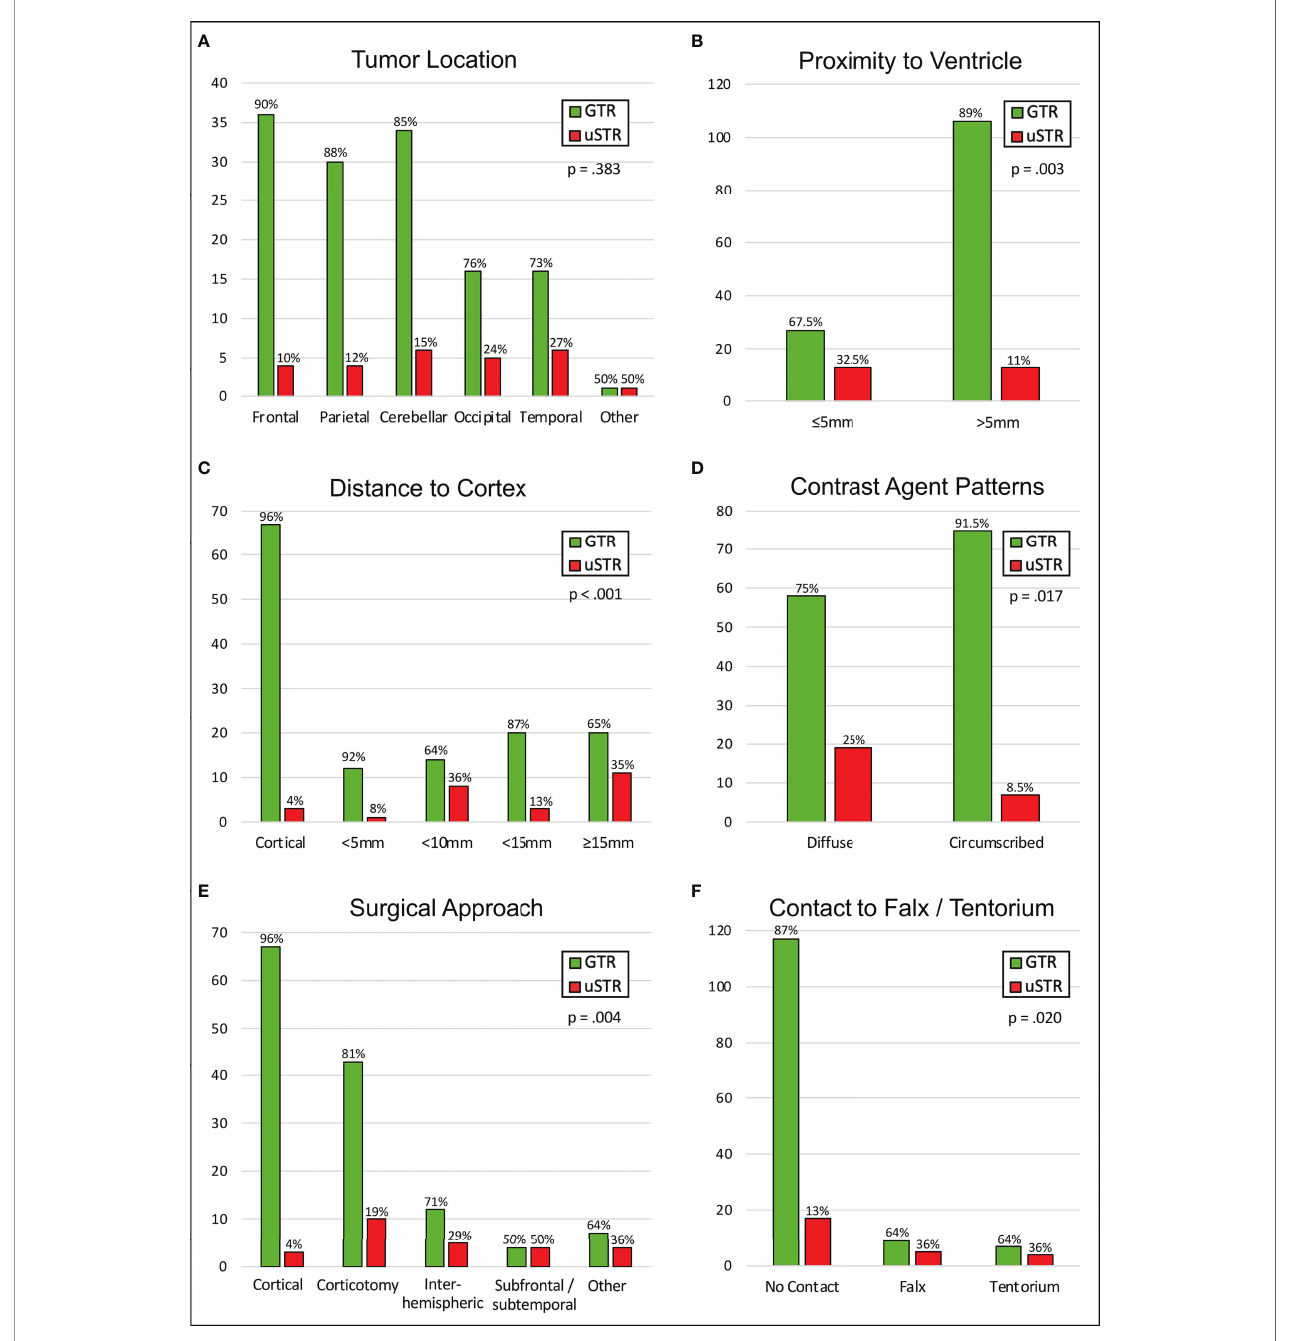
FIGURE 2 | Univariate analysis of the EOR. Bar graphs showing the relationship between the EOR and the tumor location (A) , the distance to the ventricle system (B) /to the cortex (C) , the contrast agent patterns (D) , the chosen surgical approach (E) and to the falx-tentorium contact (F) . GTR, gross total resection, uSTR, unintended subtotal